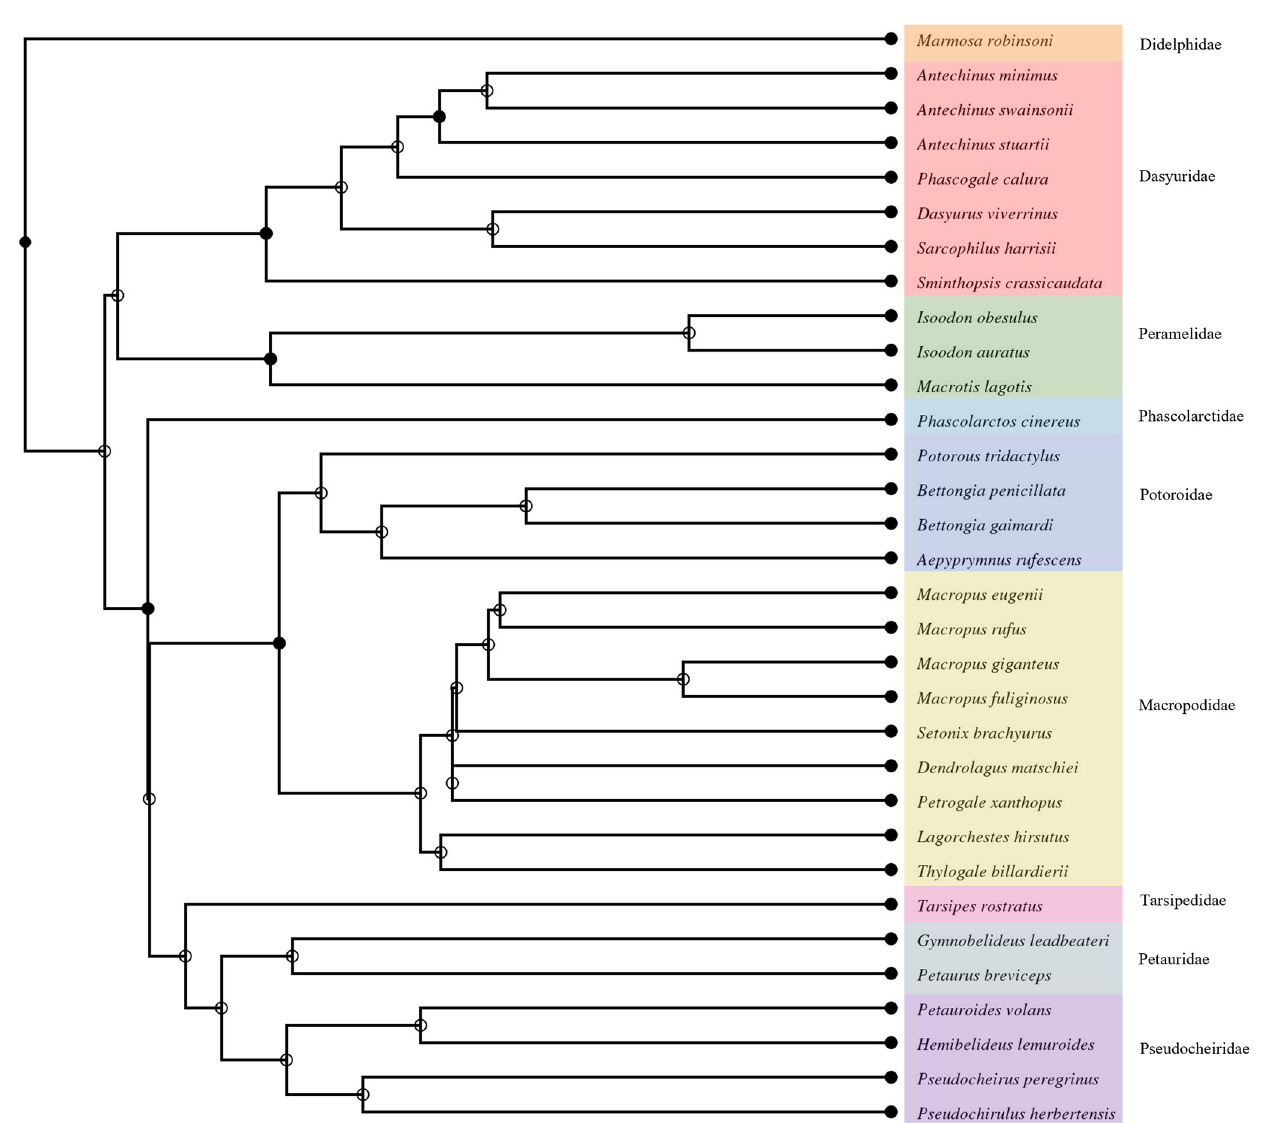
Fig 1. Phylogram of marsupial species used in the comparative TEE dataset. The phylogenetic structure was pruned from the TimeTree supertree (Kumar et al., 2017). Solid circles indicate nodes that map directly to the National Center for Biotechnology Information (NCBI) Taxonomy and the open circles indicate nodes that were created during the polytomy resolution